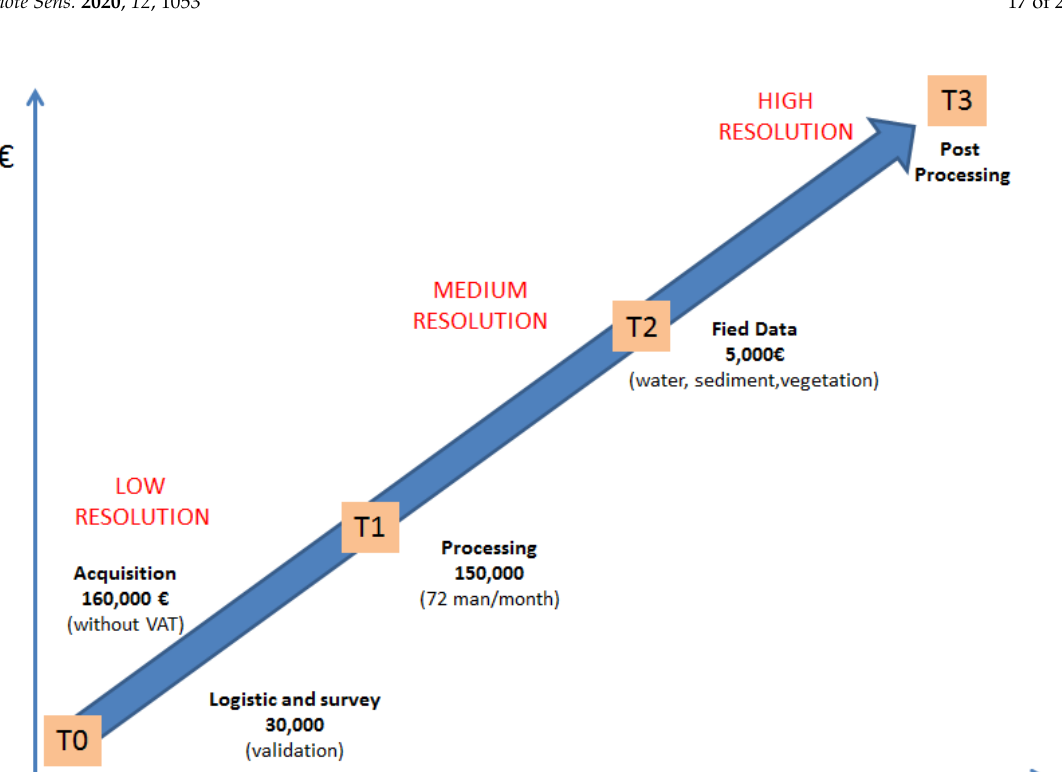
Figure 13. Visual representation of costs in relation to the resolution of obtained results.